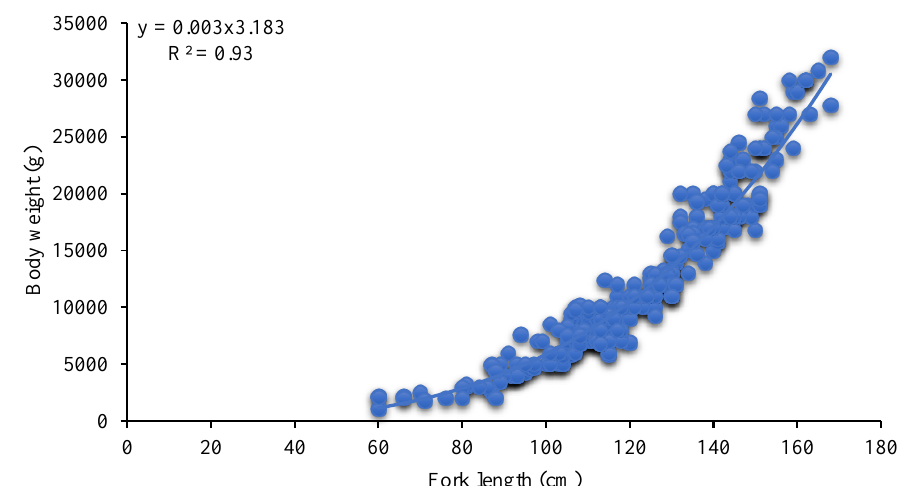
Figure 3. Relationship between body weight and fork length of Acanthocybium solandri in the Western and Central Pacific Ocean.